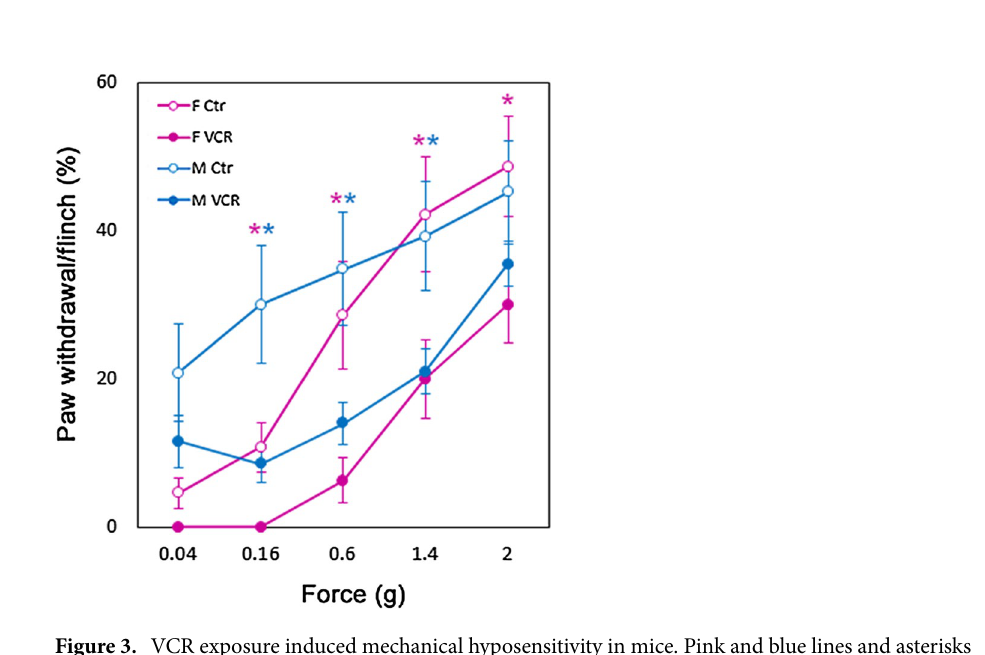
Figure 3. VCR exposure induced mechanical hyposensitivity in mice. Pink and blue lines and asterisks represent female and male mice, respectively. Open and filled circles represent the control and VCR groups, respectively. Mean ± SE, *p < 0.05 between two groups. Figures were prepared using GraphPad Prism 8.4.3 (https:// www. graph pad. com/ scien tific- softw are/